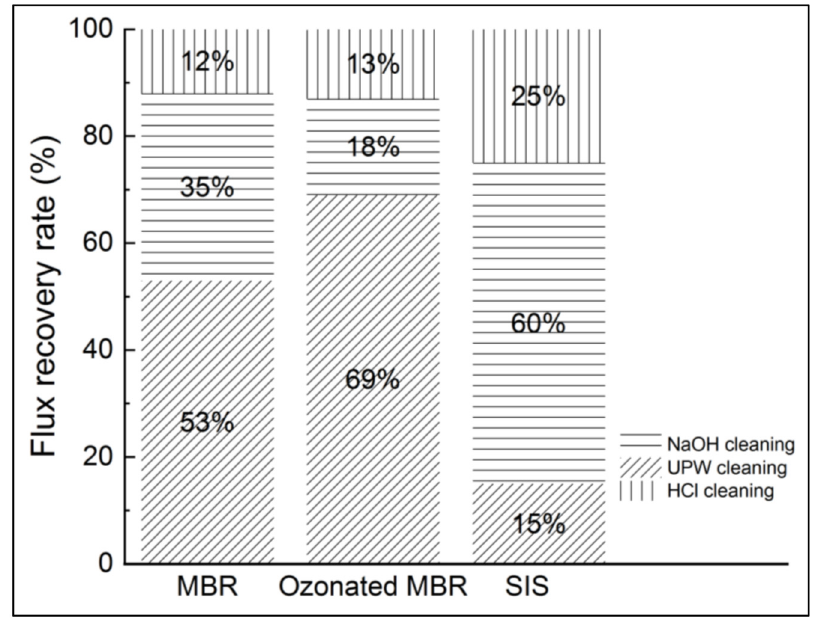
Figure 10. Flux recovery after pure water, NaOH and HCl cleanings in NF experiments applied to non-ozonated and ozonated real MBR effluent and synthetic ionic